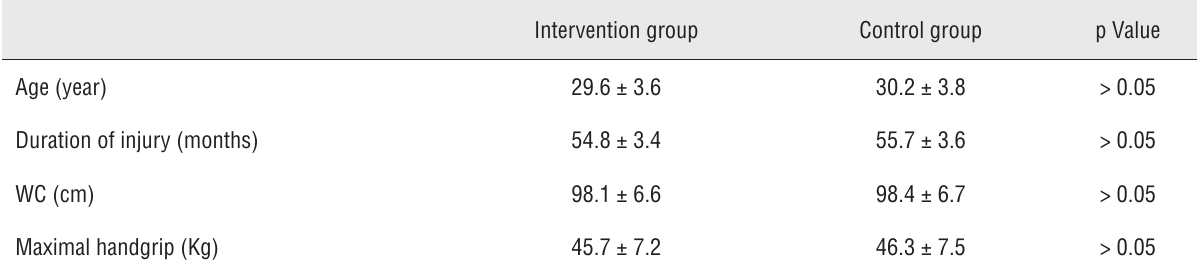
Table 1 - Participant´s characteristics at baseline in the intervention (n = 9) and control (n = 8)